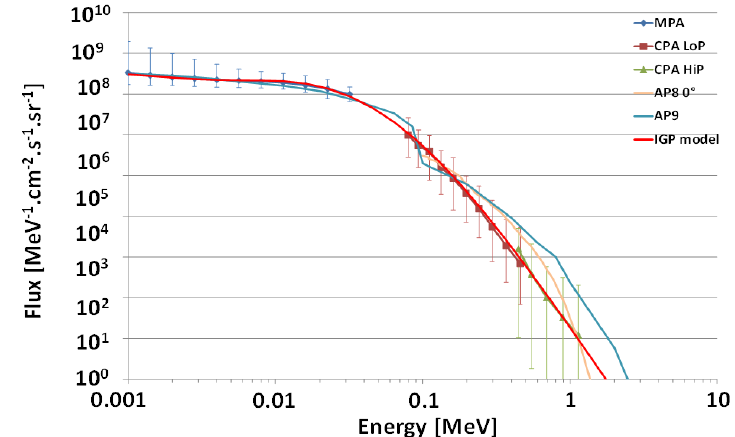
Figure 12. Total spectrum of trapped protons deduced from MPA and CPA measurements on board different LANL satellites and from the model. Fluxes from AP8 and AP9 are provided for